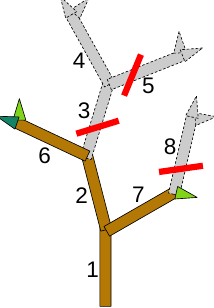
3,5,8 is a pruned tree model (cid:104) (cid:105)